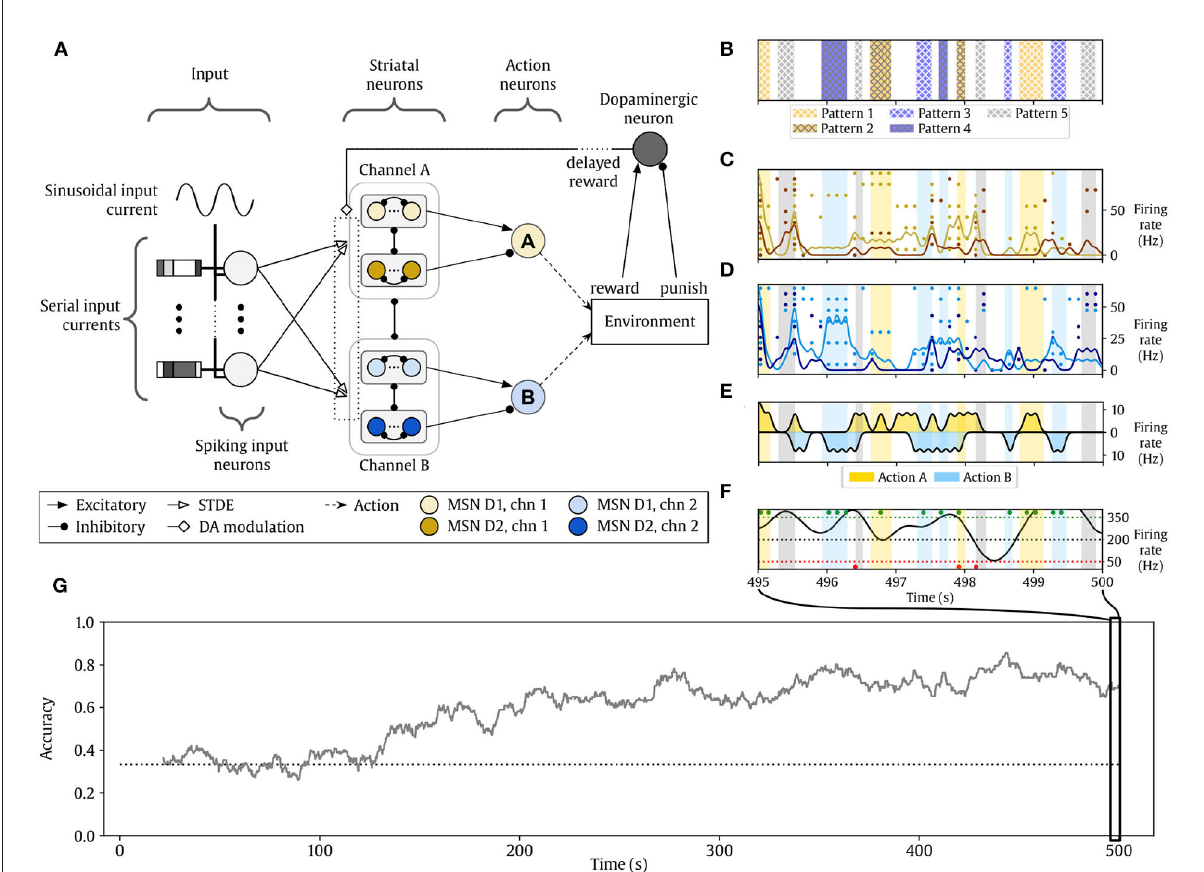
FIGURE1 Cortico-striatal network solving a reinforcement learning (RL) task (from Gonzalez-Redondo et al. 2022). (A) Structure of the network. (B–F) The activity of the network during the last 5 s of simulation. Background color indicates the reward policy (yellowish colors, action A is rewarded and B is punished; bluish colors, action B is rewarded and A is punished; gray, any action is punished). (B) Input pattern conveyed to the input layer. (C) Raster plot of the channel-A action neurons. Yellow dots represent STR D1 spikes, and orange dots are STR D2 spikes. (D) Raster plot of channel B. Cyan dots represent STR D1 spikes, and dark blue dots are STR D2 spikes. (E) Action neuron firing rates. The middle horizontal line represents 0 Hz. Action A and B activities are represented in opposite directions for clarity. Action A neuronal activity increases in yellow zones while action B neuronal activity in cyan intervals. (F) Firing rate of the dopaminergic neuron (black line). Dotted horizontal lines indicate the range of dopamine activity considered: black is the baseline, green is the maximum reward, and red represents the maximum punishment. Dots indicate rewards (green) and punishment (red) events delivered to the agent. (G) Evolution of the learning accuracy of the agent, see Section 2.1 for further details. The dotted line marks the accuracy level by